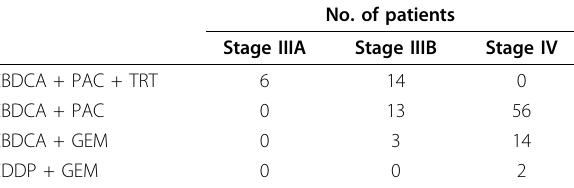
Table 2 Treatment characteristics of the enrolled patients